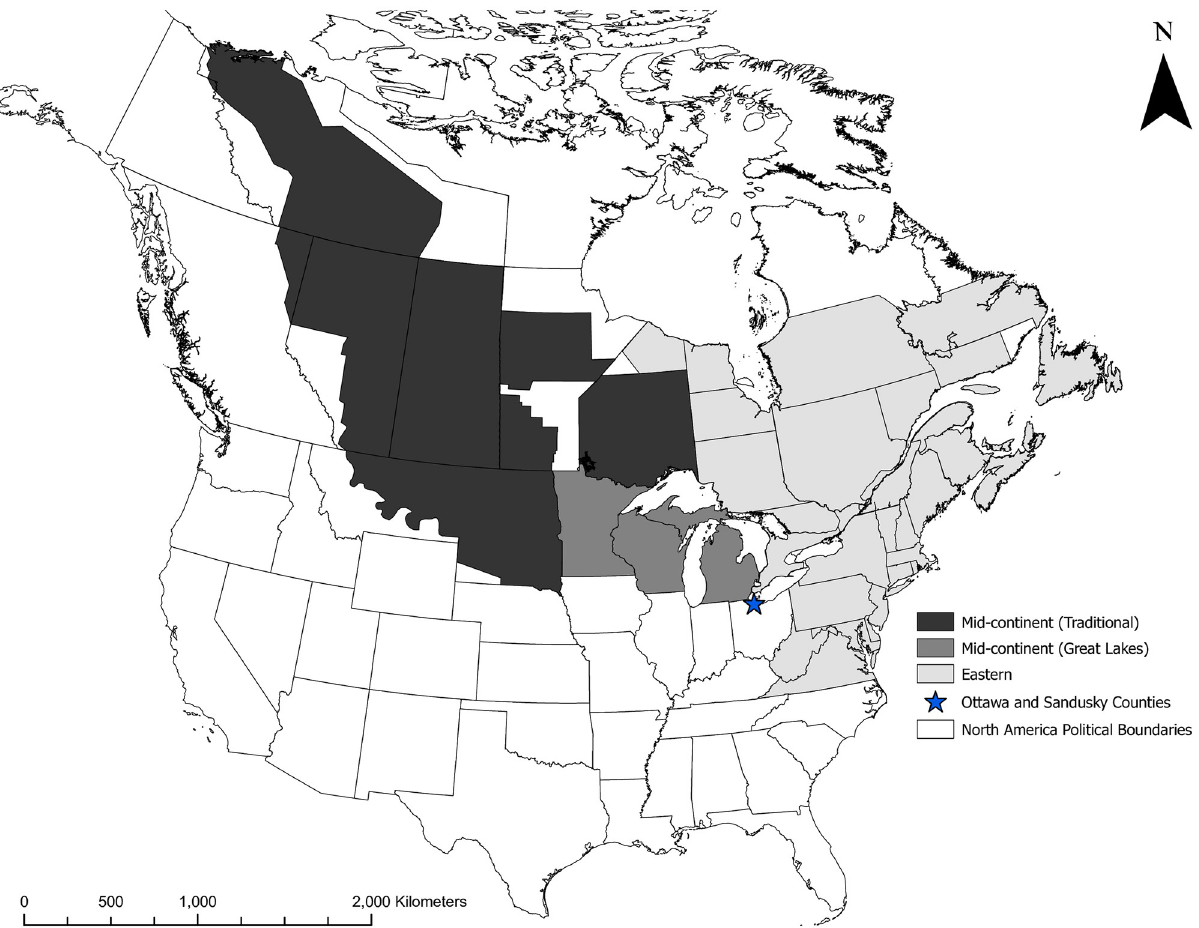
Fig 1. Waterfowl survey areas currently assigned to the eastern and mid-continent stocks of mallards as identified by the United States Fish and Wildlife Service (USFWS) for management purposes. Spatial layers of populations were provided by the USFWS and base outline political boundary layers are free, open-source from ESRI. WBPHS, Eastern Survey, and Great Lakes shapefiles were provided by USFWS. U.S. political boundaries were obtained through the U.S. Census Bureau (https://www.census.gov/geographies/mapping-files/time-series/geo/carto-boundary-file.html). Canadian province political boundaries were obtained through Open Canada census Bureau (https://open.canada.ca/data/en/dataset/a883eb14-0c0e- 45c4-b8c4-b54c4a819edb). Except for the shapefiles listed above, no external data was used for the creation of the figure. ESRI ArcMap 10.8 was used for the creation of the